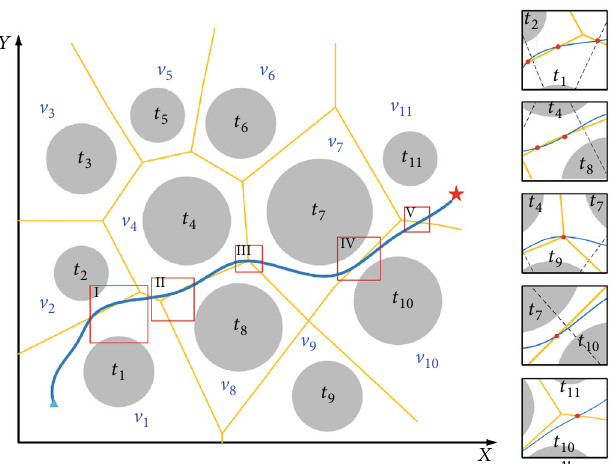
Figure 11: The distribution of Ξ k :